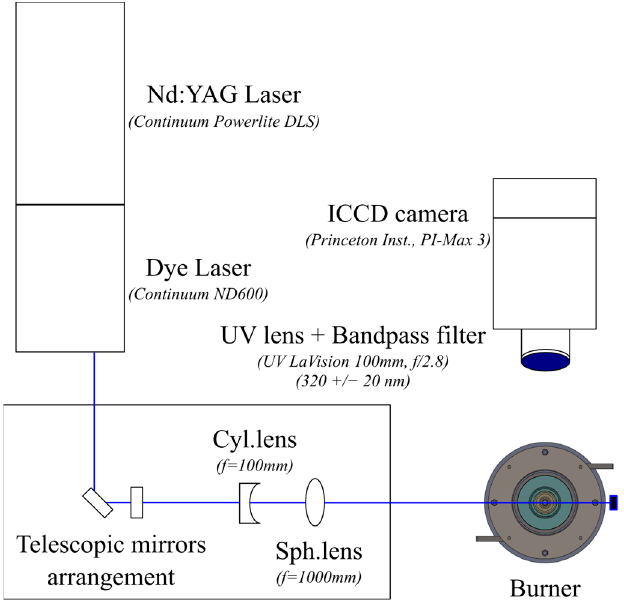
Figure 2. Schematic of the OH-PLIF setup.